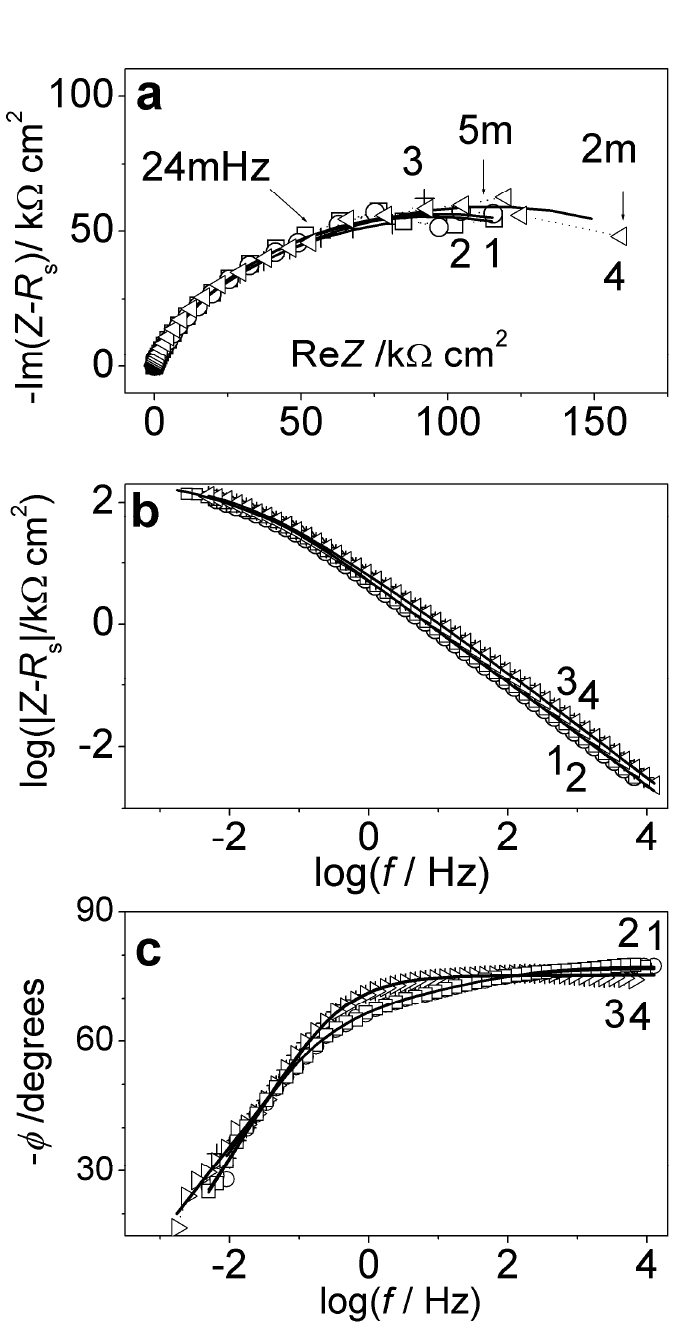
Fig. 10 Measured and calculated (according to the EC model of Fig. 9a.) impedance diagrams determined at the corrosion potentials of two parallel electrodeposited samples after 18 h corrosion immersion followed the SWPC treatment: 1,2 and 3,4 are the suc- cessively measured spectra of each sample, respectively. E corr values were: 1-o- –0.086 V; 2 -x- –0.089 V; 3- + − –0.296 V; 4- ∇ - –0.299 V. (a) in complex plane: 1-4 measured, solid line- fitted data; (b) and (c) the corresponding Bode plots: 1-4 –with symbols the measured, with solid lines the fitted